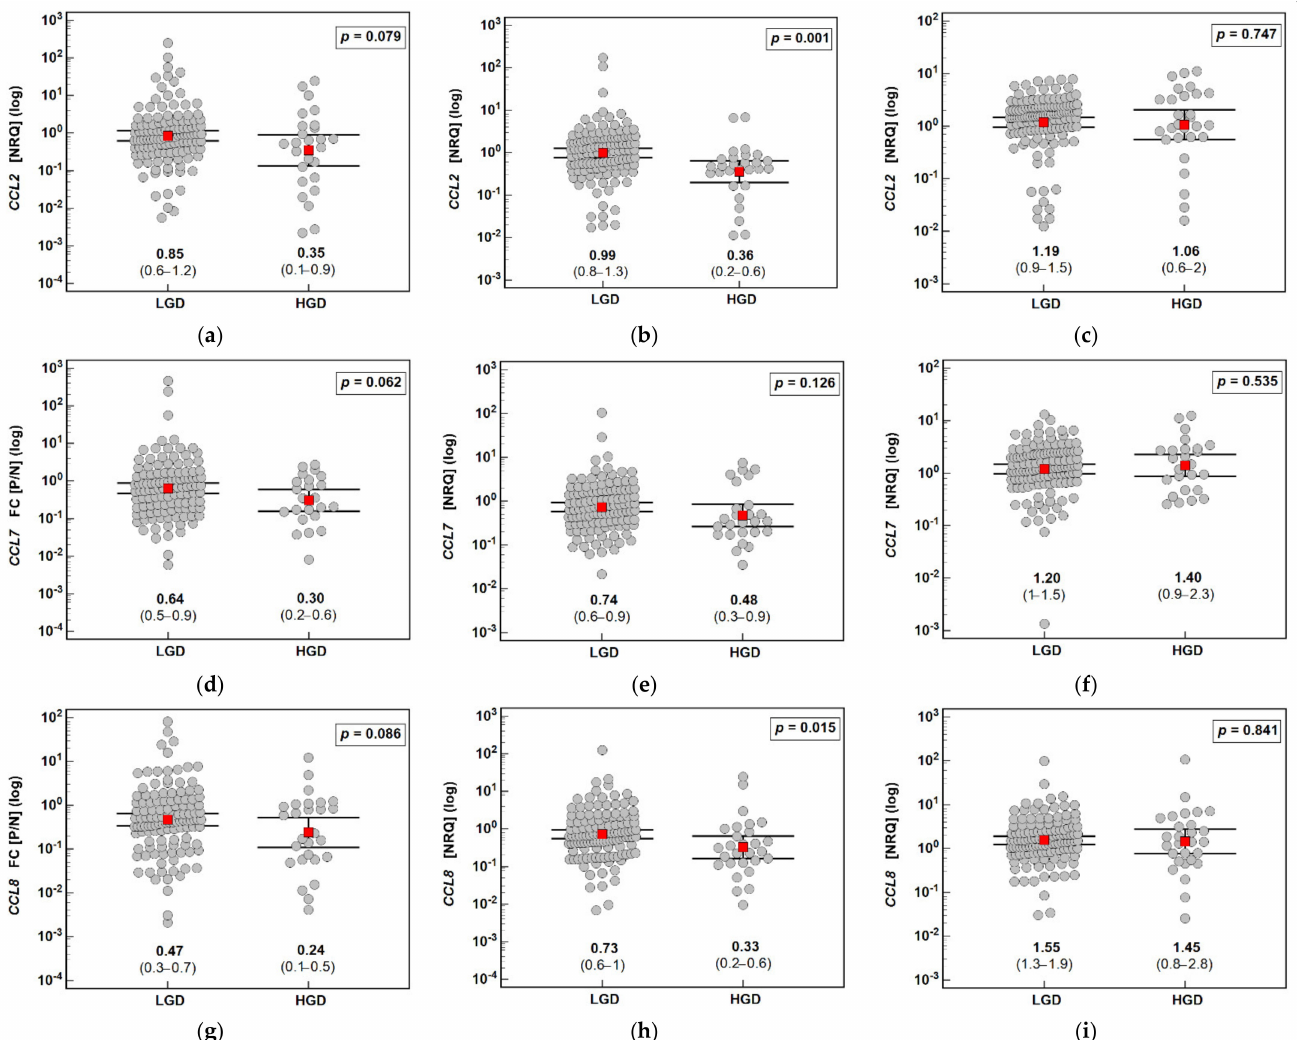
Figure 6. Effect of the dysplasia grade on the expression (mRNA) of MCP chemokines in patients with colorectal polyps: ( a ) fold change (FC) in CCL2 expression between the polyp and normal mucosa (P/N); ( b ) CCL2 expression in a polyp; ( c ) CCL2 expression in normal tissue; ( d ) fold change (FC) in CCL7 expression between the polyp and normal mucosa (P/N); ( e ) CCL7 expression in a polyp; ( f ) CCL7 expression in normal tissue; ( g ) fold change (FC) in CCL8 expression between the polyp and normal mucosa (P/N); ( h ) CCL8 expression in a polyp; ( i ) CCL8 expression in normal tissue. Data analyzed as logarithms using a t -test for independent samples with Welch correction in the case of unequal variances and presented as means with 95% confidence intervals (red squares with whiskers and numbers below dot plots). NRQ: normalized relative quantity; LGD: low-grade dysplasia; HGD: high-grade